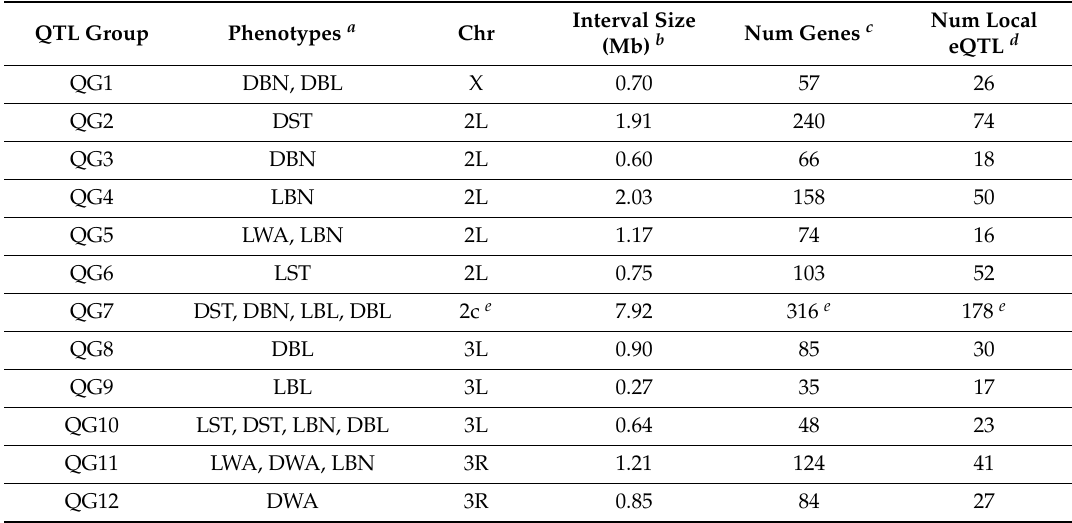
Table 1. Details of mapped QTL